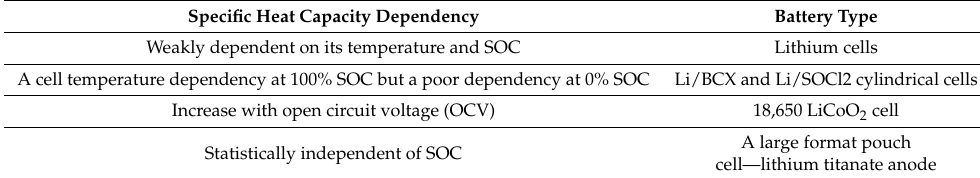
Table 6. The influence of bulk temperature and SOC on the specific heat capacity of lithium cells